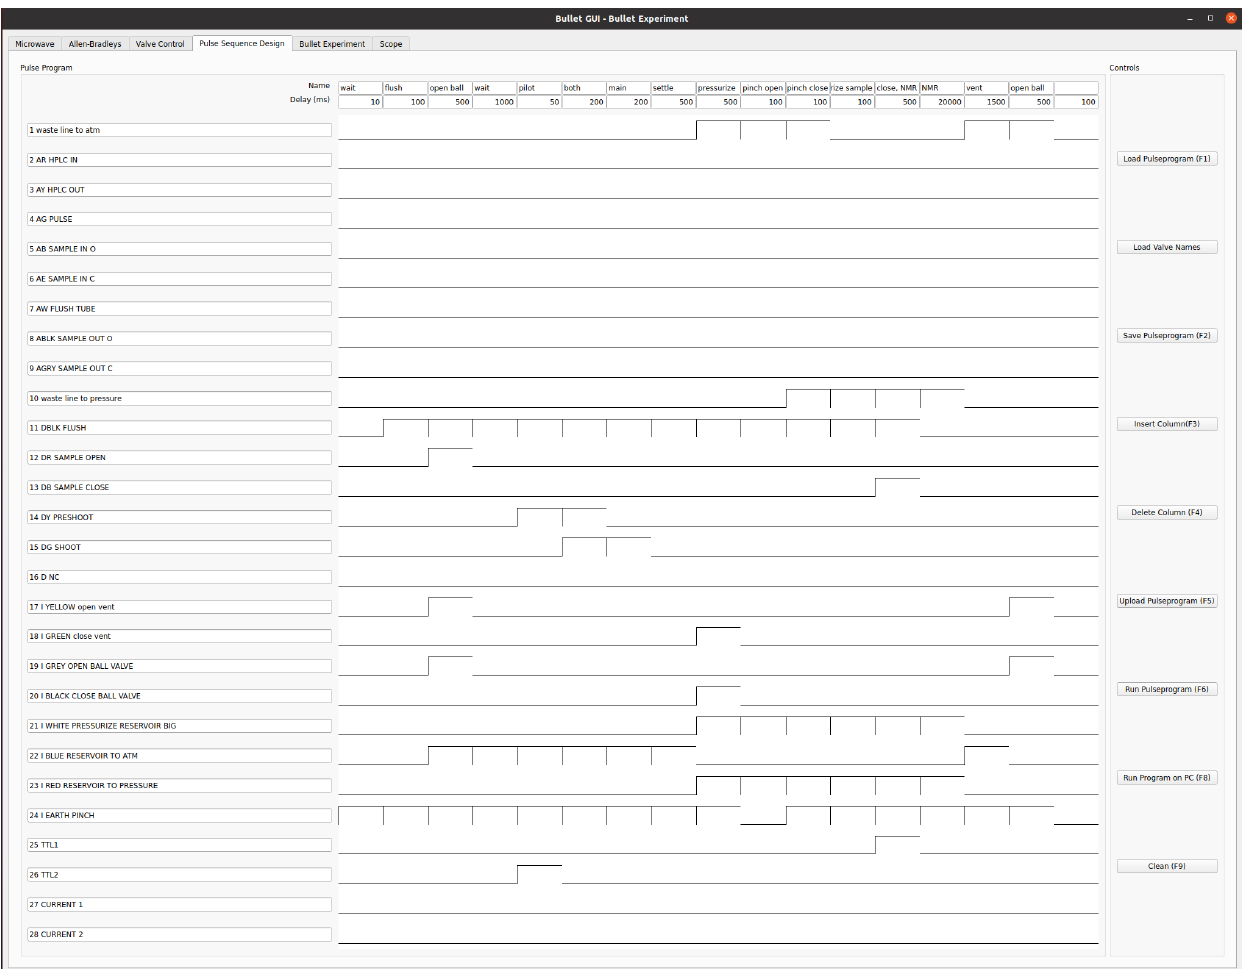
Figure C1. Bullet pulse program for sample ejection, dissolution, and injection. The lines 1 to 24 correspond to digital output lines that are connected to pilot valves. The program runs through a sequence of 17 steps. The duration of each step is given in the top row, under its name. Valve 1 connects the outlet of the NMR tube to the atmosphere. Valves 2–9 are not used. Valve 10 connects the output line of the NMR tube to back pressure. Valve 11 applies flush gas on top of the DNP insert, and valves 12 and 13 are used to open and close the ball valve on the DNP insert top, respectively. Valves 14 and 15 apply helium drive gas to the DNP insert via the pilot and main line, respectively, and are used to propel the sample. Valves 17 and 18 open and close a ball valve that is connected to the vent line of the DNP injection device. Valves 19 and 20 open and close the ball valve on the injector. The line above the solvent reservoir can be pressurized with helium (3bar) using valve 21. Helium pressure can also be applied directly to the solvent reservoir via valve 23. Finally, valve 24 controls the pinch valve, which is only opened briefly to inject the sample into the NMR tube. The line TTL1 outputs a TTL signal that triggers the NMR acquisition, and the TTL2 signal triggers a scope which measures optical signals and the tunnel